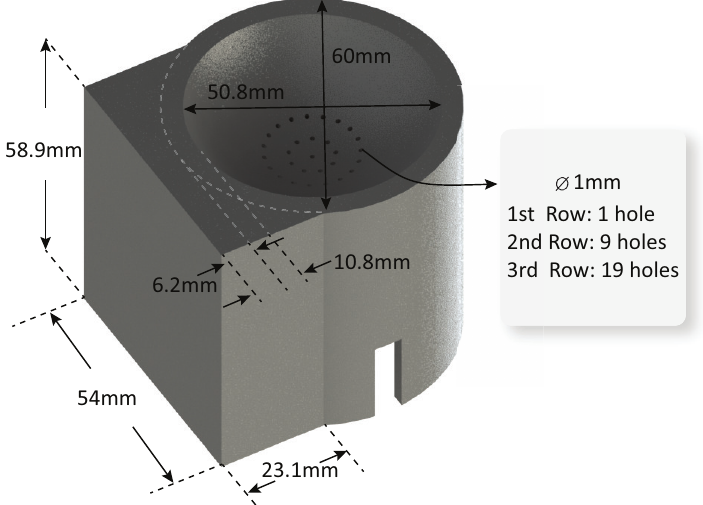
Figure 3. Bottom part of air bearing.